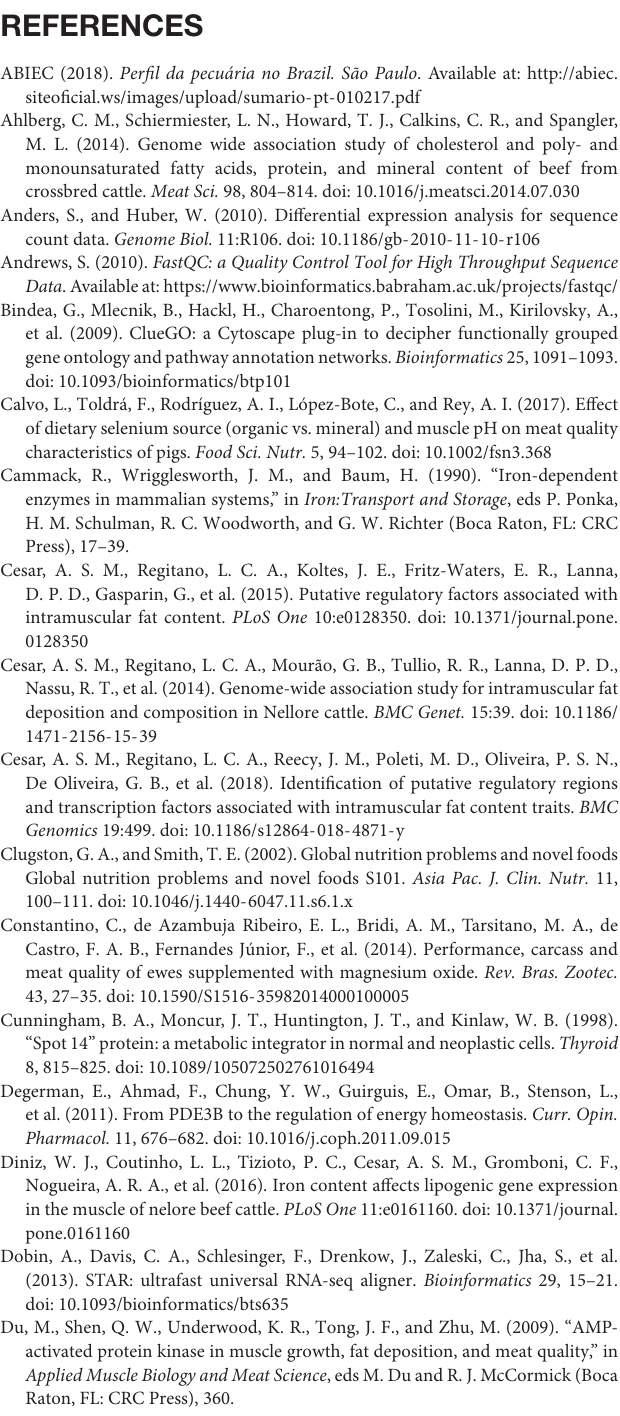
TABLE S1 | Summary statistics of meat quality traits and mineral concentration in Nelore cattle. TABLE S2 | The proportion of variance explained by the module eigengene (MEs).